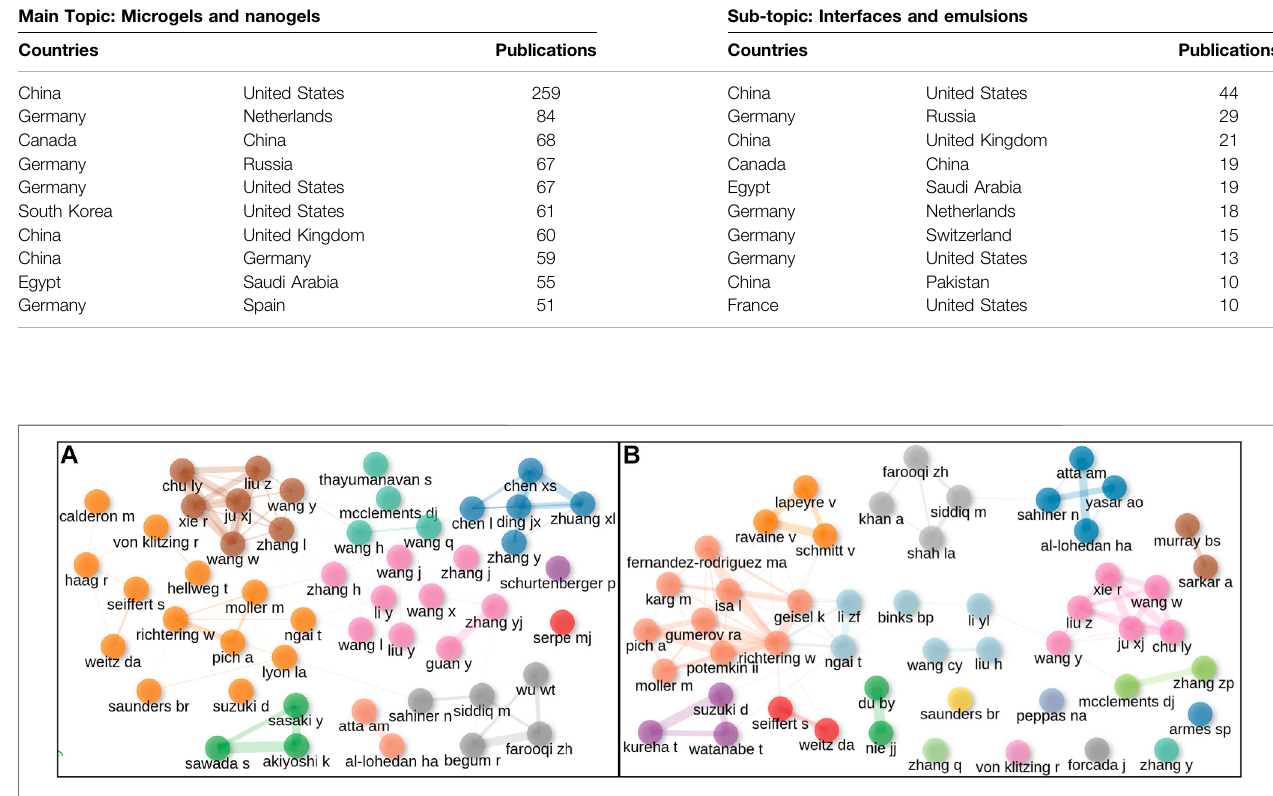
Frontiers in Physics |